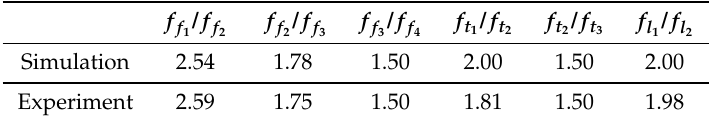
Table 1. Ratios of successive natural frequencies obtained by simulation and experiment. The ratios are independent of the elastic parameters.